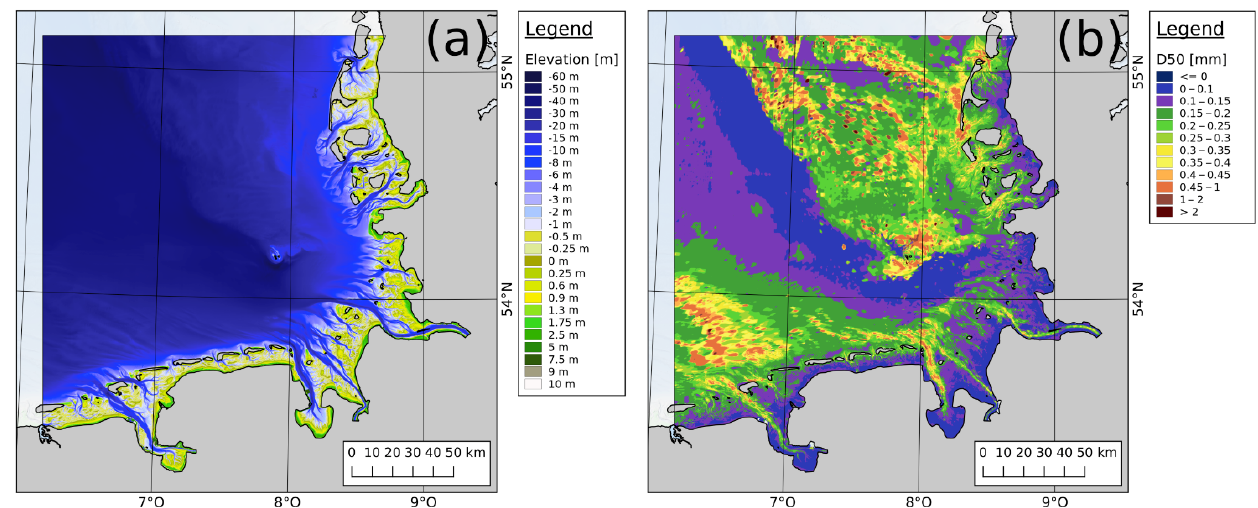
Figure 7. Exemplary base products for 1996 for (a) bathymetry and (b) surface sedimentology painted as median grain diameter.